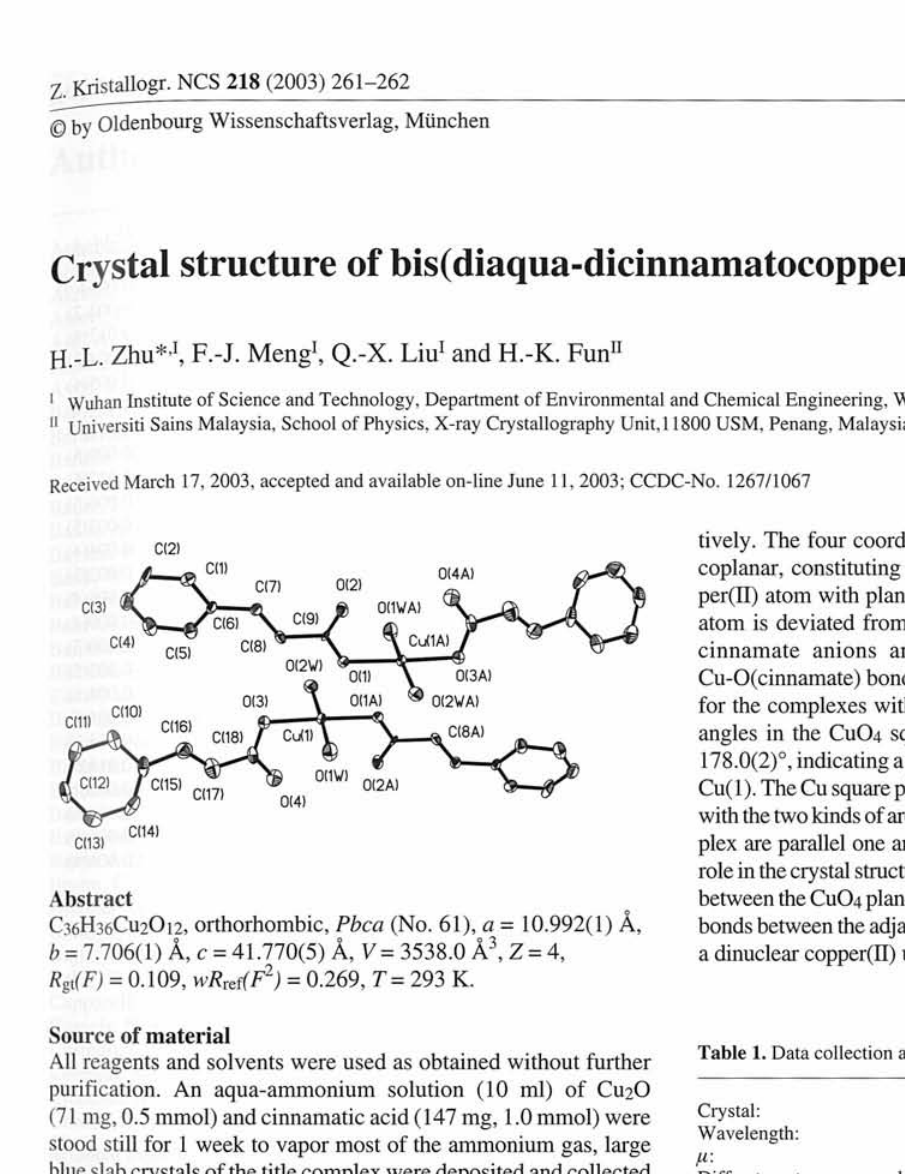
Table 1. Data collection and handling.